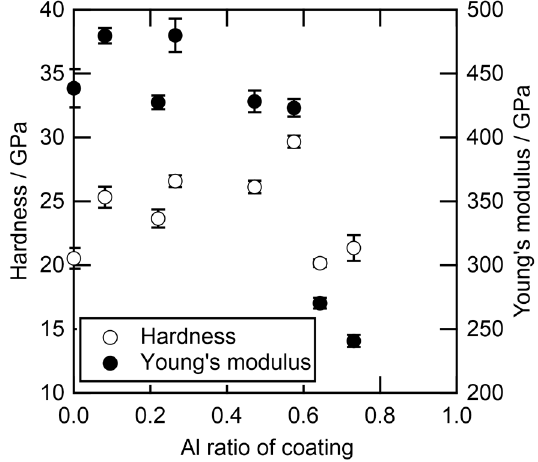
Figure 5. Hardness and Young’s modulus of TiAlN coatings measured by nano-indentation.